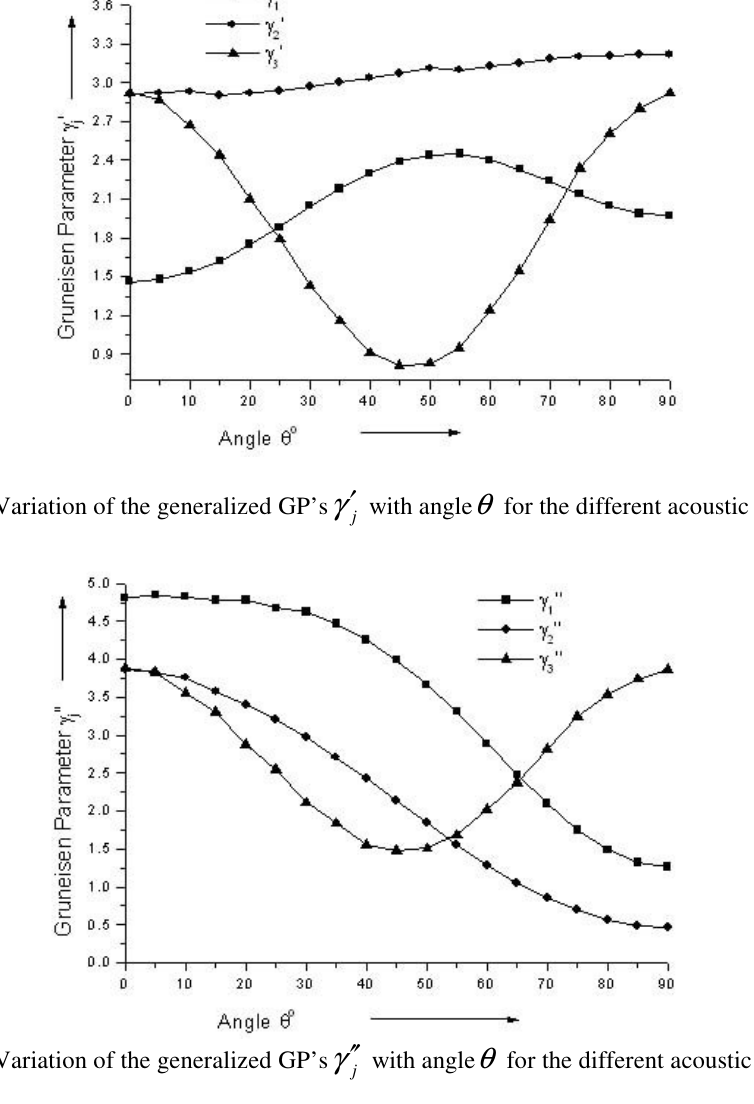
Figure 2 Variation of the generalized GP’s